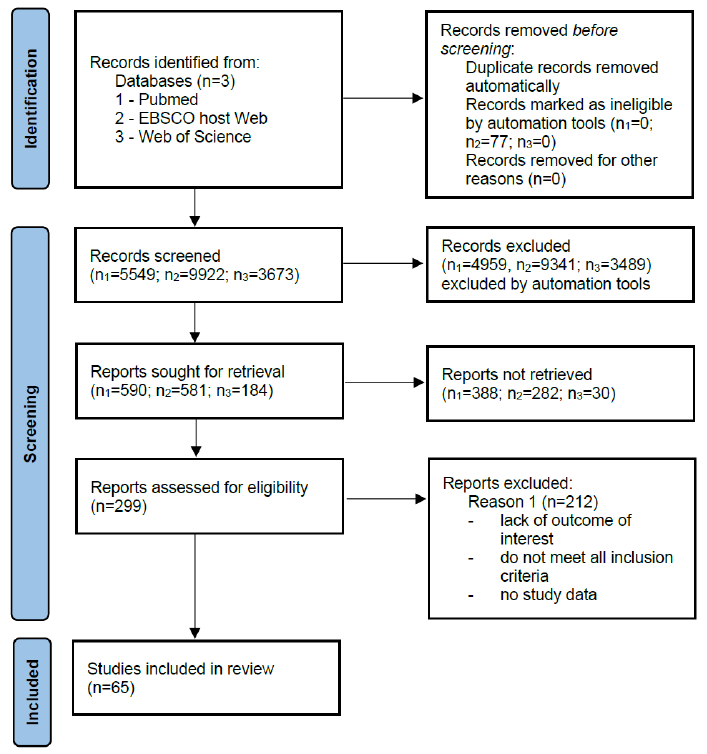
Figure 1. Literature search strategy. A total of 65 articles included studies of selected adipokines, of which 19 articles reported quantification of these proteins in blood and ascites.